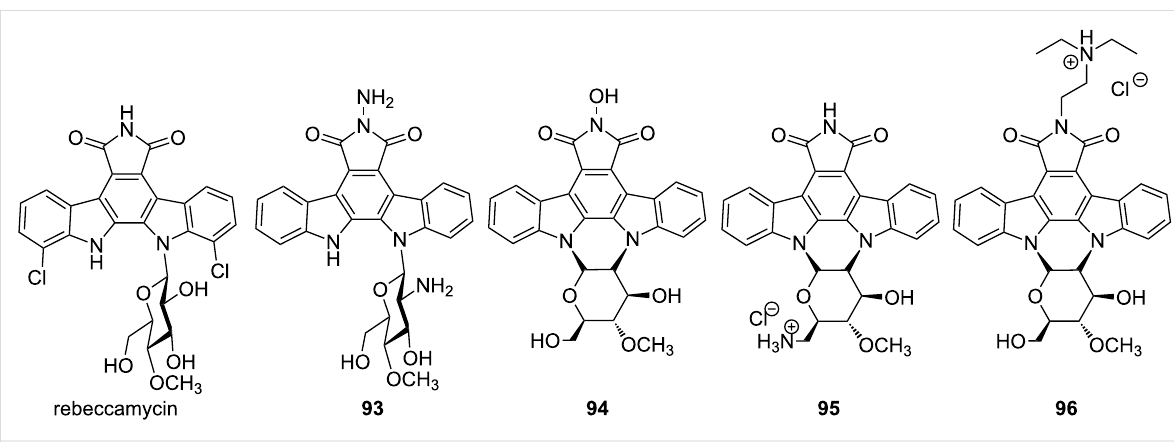
Figure 15: Naturally occurring indolocarbazole rebeccamycin and its synthetic